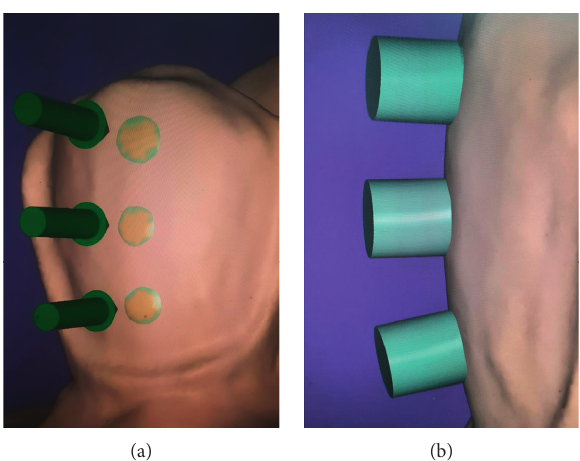
Figure 1: (a) Design of digital die spacer on the buccal surface. (b) Design of microdisc on the buccal surface.